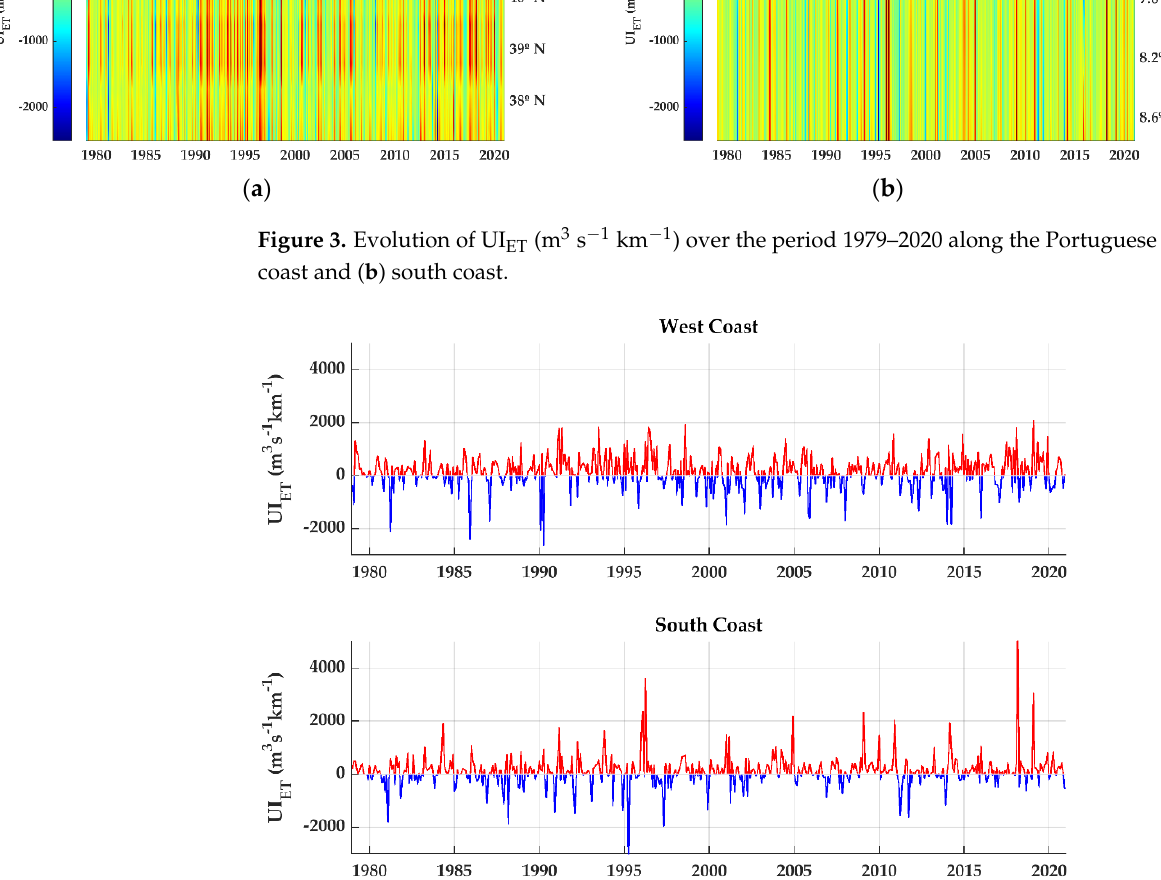
Figure 4. Spatial averages of the evolution of UI ET (m 3 s − 1 km − 1 ) on the Portuguese west and south coasts over the period 1979–2020. The red line represents positive values, and the blue line represents negative values.